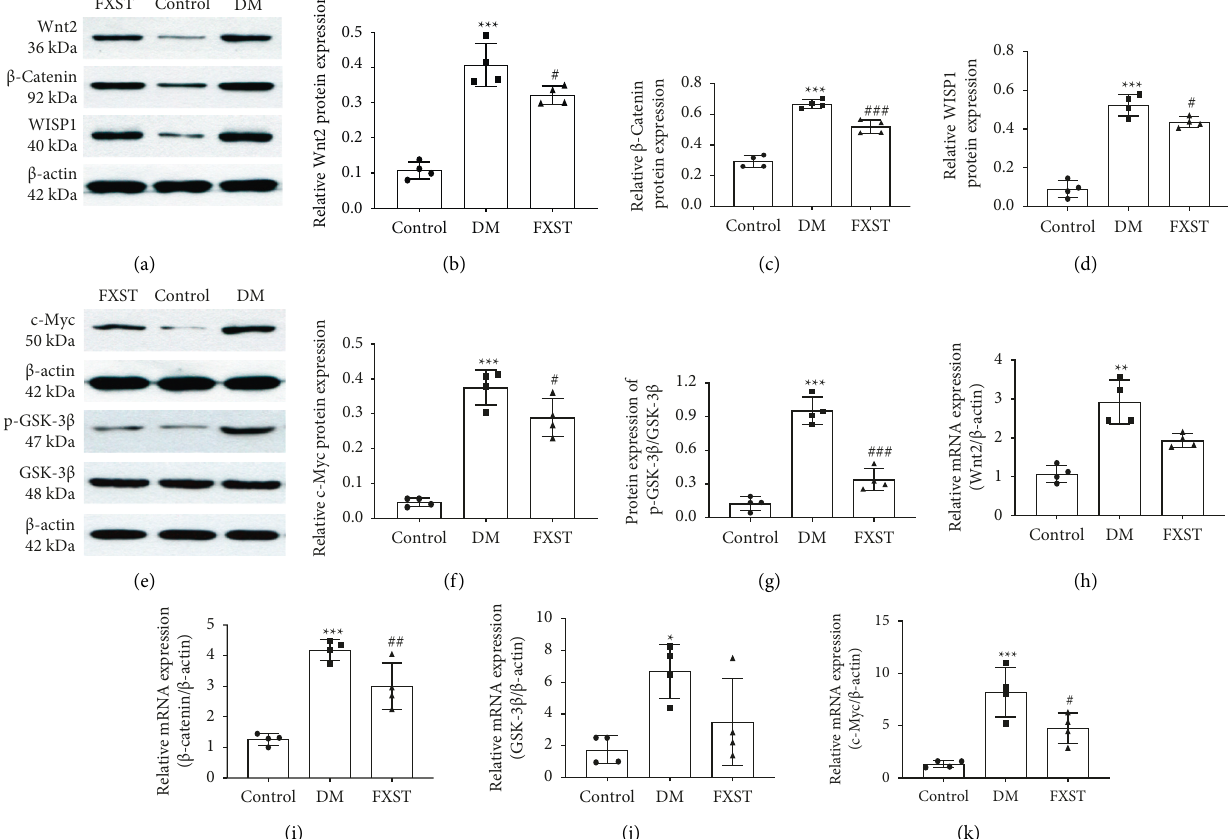
Figure 5: FXSTattenuated diabetic cardiomyopathy by regulating the Wnt/ β -catenin pathway. (a-g) Western blot was used to determine the protein expression of Wnt2, β -catenin, WISP1, c-Myc, and p-GSK-3 β in the myocardial tissues of rats in each group. (h-k) Real-time PCR was performed to measure the mRNA expression of Wnt2, β -catenin, GSK-3 β, and c-Myc in the myocardial tissues of rats in each group. Data are expressed as the mean SD ( n 4 for each group). (cid:31) 0 . 001 vs. the DM ± <